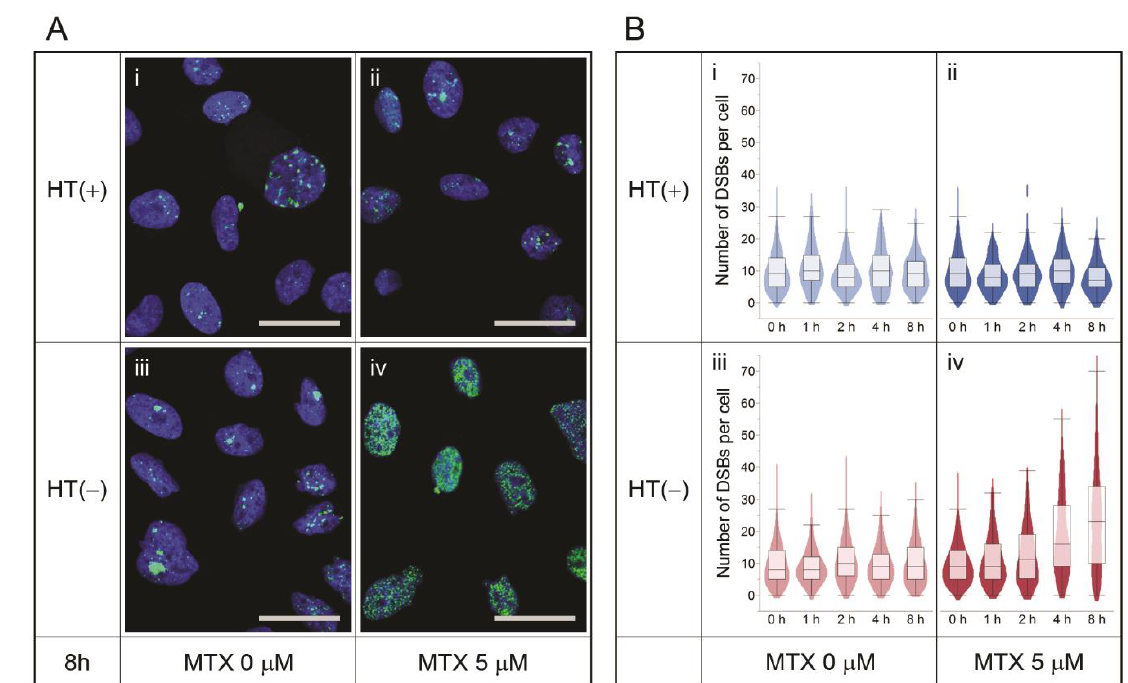
Figure 5. ( A ) Immunocytochemistry of γ H2AX (green foci) on Dhfr -expressing (CHO-K1) cells, which represent production cells in the MTX-mediated gene amplification system, in the presence or absence of HT or MTX or both. The nuclei are counterstained with DAPI. ( B ) The number of DSBs per cell and their distribution at each time point. The scale bars are 20 µm .